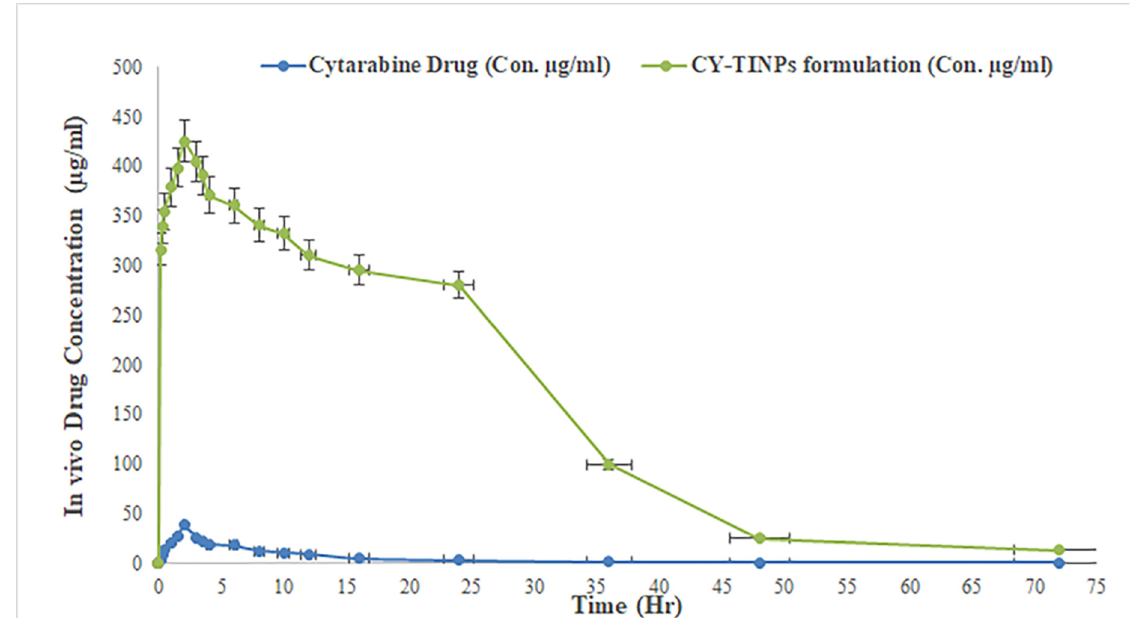
Figure 12. Depicts the serum concentration vs. time trends following single dose administration of cytarabine solution and CY-TINPs formulation. Table 2. Depicts the In vivo pharmacokinetic parameters for cytarabine drug and CY-TINPs formulation.